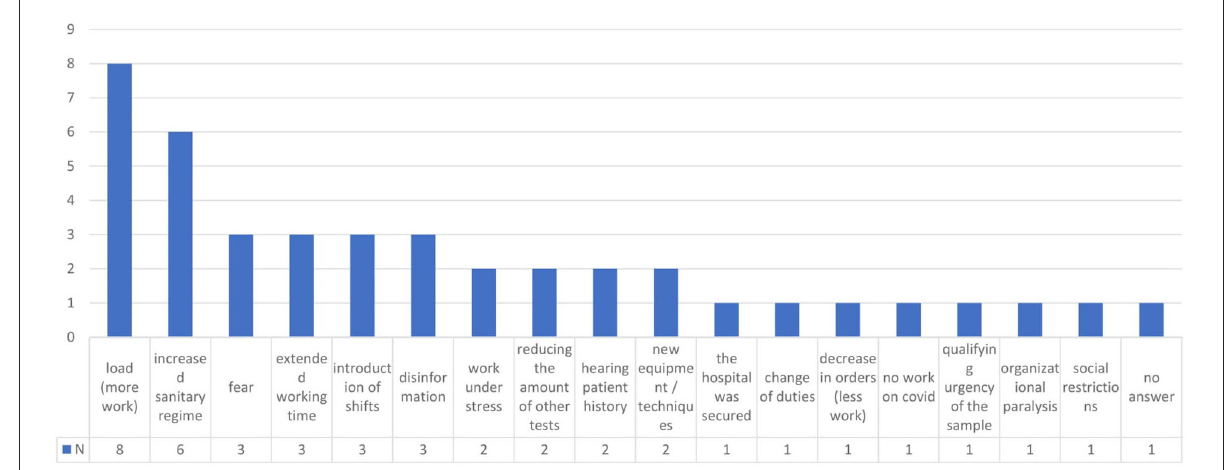
FIGURE1 Interview responses regarding the experience from the beginning of the pandemic ( N =